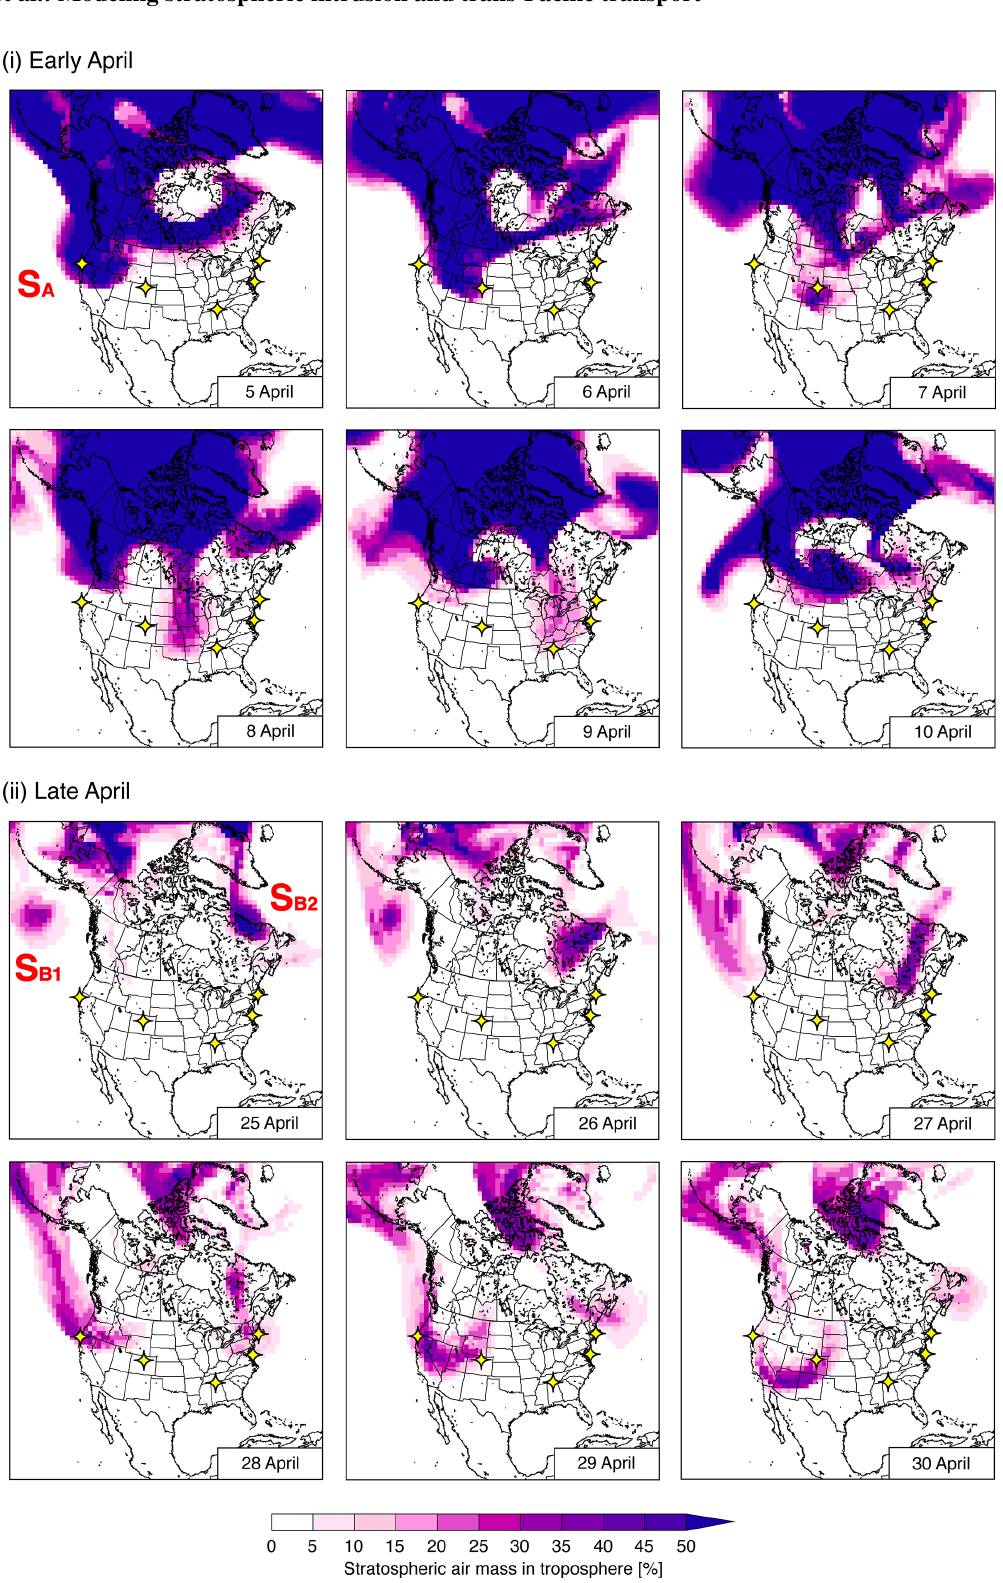
Figure 12. Spatial distributions of day-to-day variations of stratospheric air mass contributions to total tropospheric O 3 column over the US during (i) early and (ii) late April 2010. Yellow stars indicate the ozonesonde observational sites. Red character strings ( S A and S B1 − S B2 ) denote the different stratospheric air masses discussed in the